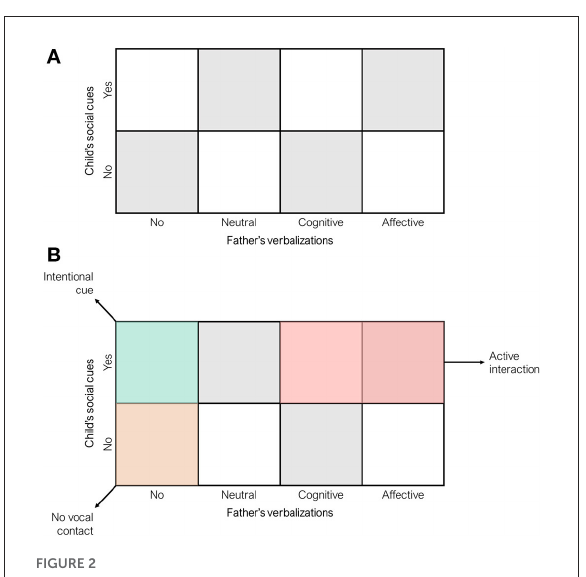
FIGURE2 State Space Grid (SSG) cells (A) and regions of interest (B) used in the present study.